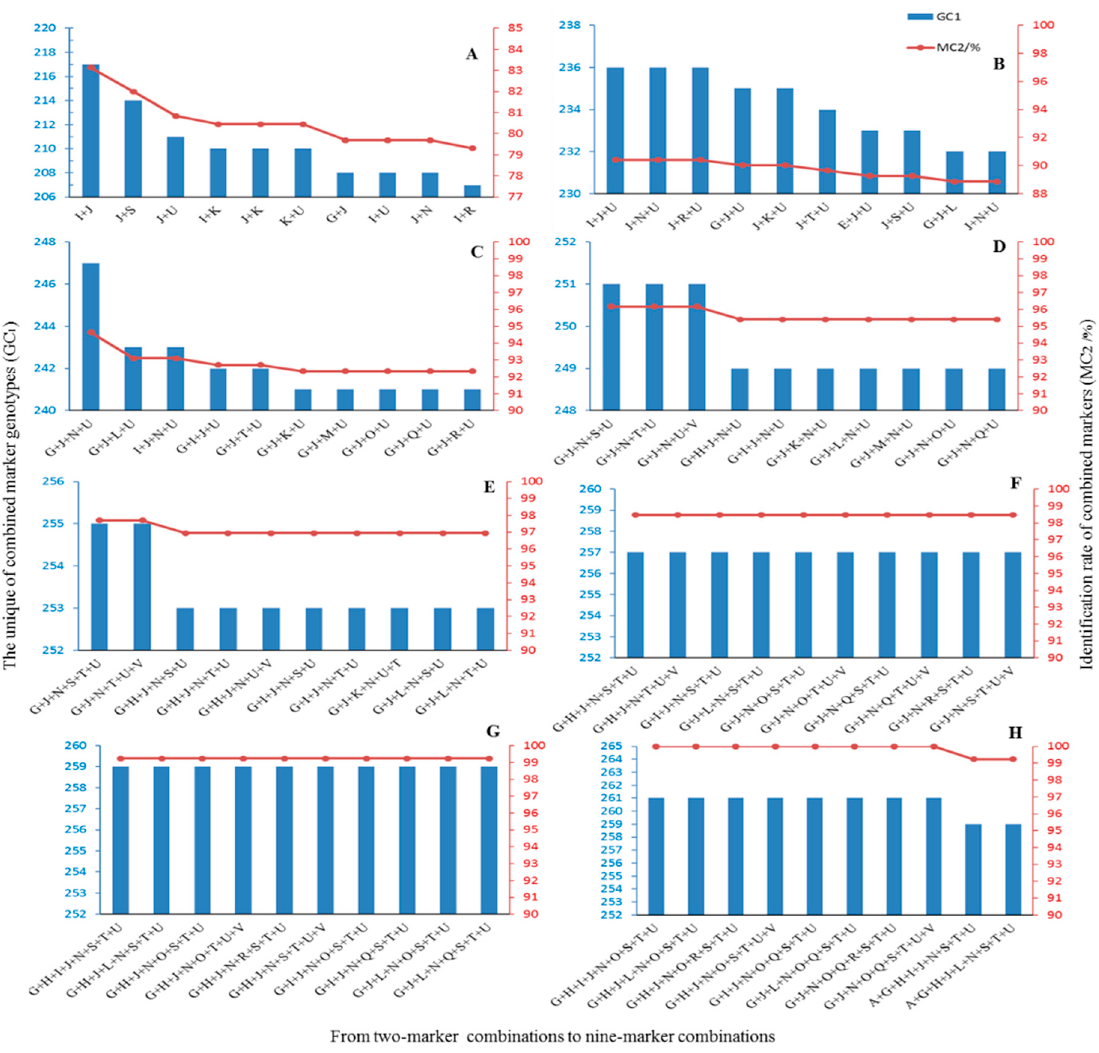
Figure 2. Estimates of the GC1 and MC2 of combined markers of SSR markers, calculated for a sample of 261 accessions of Salix psammophila , ( A ) two-marker combination; ( B ) three-marker combination; ( C ) four-marker combination; ( D ) five-marker combination; ( E ) six-marker combination; ( F ) seven-marker combination; ( G ) eight-marker combination; ( H ) nine-marker